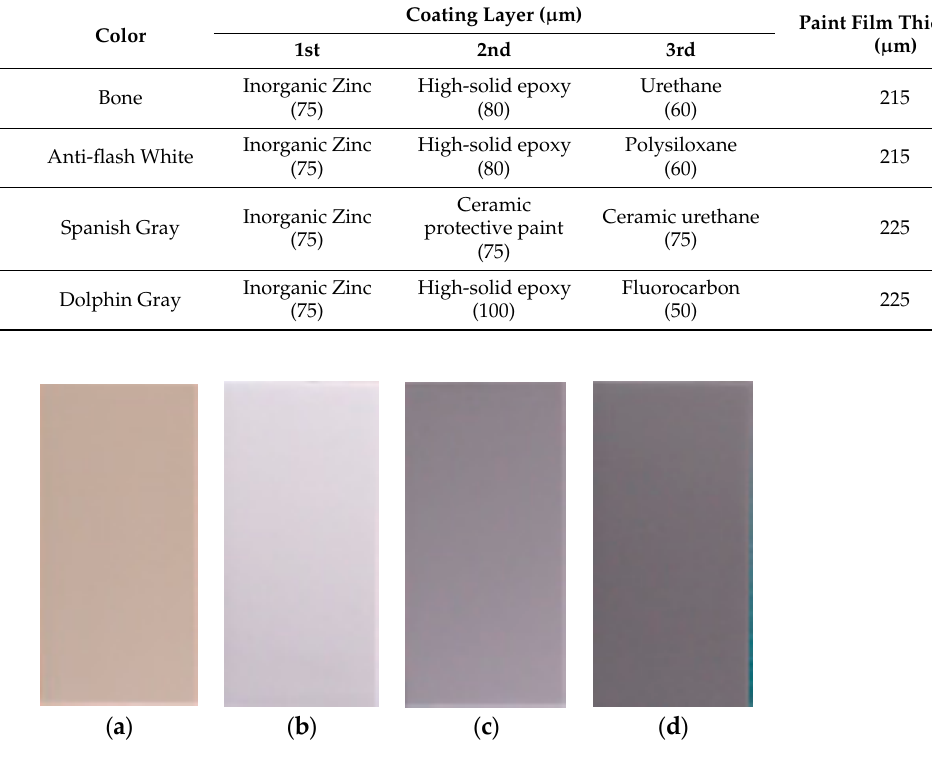
Figure 1. Painted steel specimens: ( a ) Urethane (U); ( b ) Siloxane (S); ( c ) Ceramic (C); ( d ) Fluorocar- bon